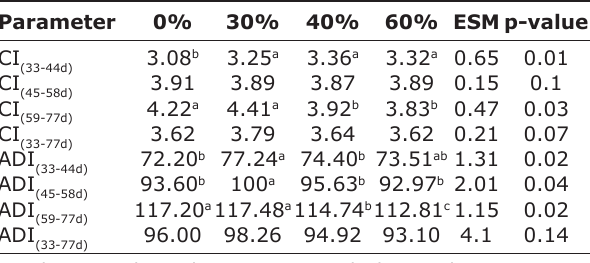
Table-5: Evolution of the CI (g/g) and ADI (g/days) during fattening of the young rabbits according to the percentage of incorporation of the DAKM and DTP